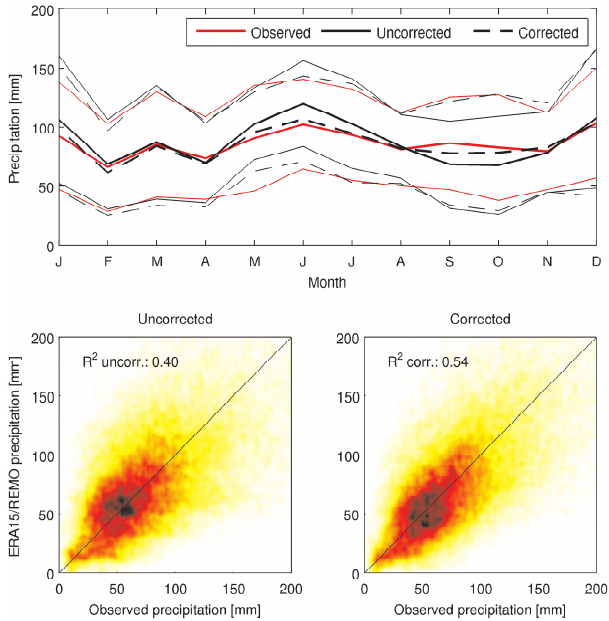
Fig. 5. Top: average monthly precipitation sums [mm] for the ob- servations and the uncorrected and corrected ERA15/REMO data (solid lines). Average monthly precipitation sums +/ − one stan- dard deviation are shown as well (thin lines); Bottom: scatter densi- ties for the uncorrected and corrected ERA15/REMO and observed monthly precipitation sums for each year per sub-basin. R 2 coeffi- cients for the uncorrected and corrected situation are shown as